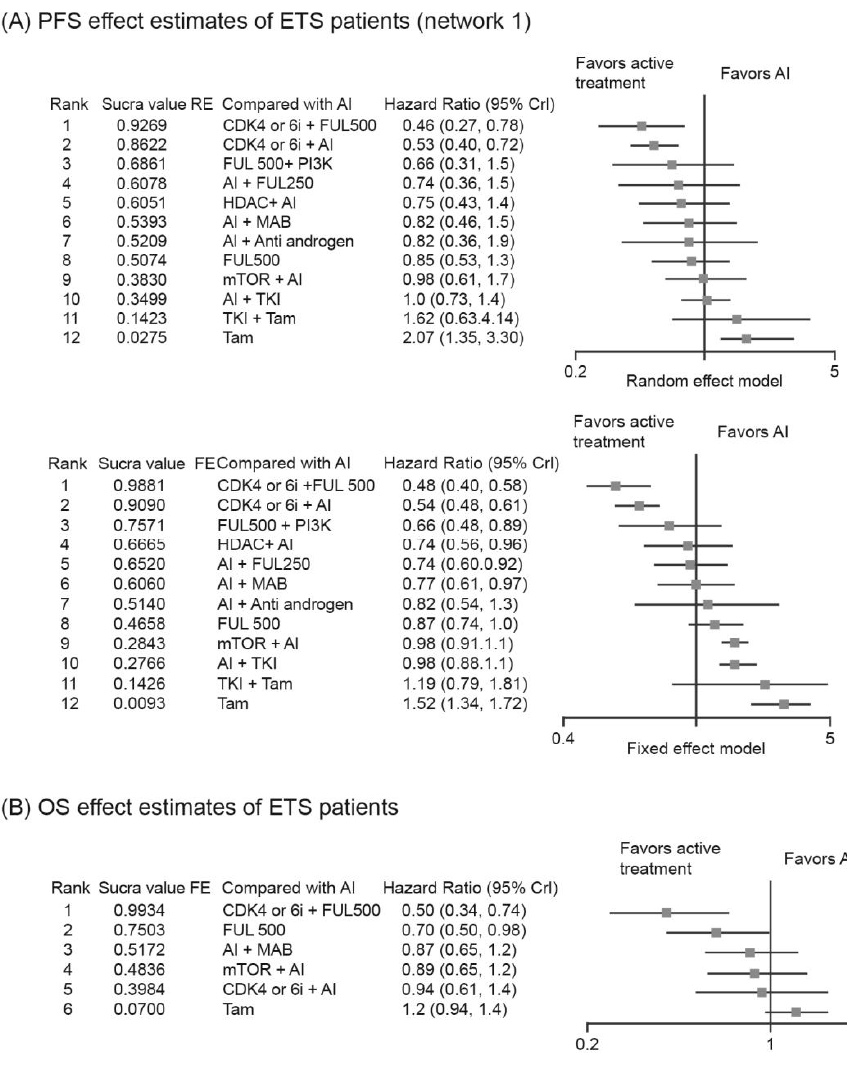
Figure 3. SUCRA values for treatment regimens and relative effect. ( A ) PFS effect estimates of ETS patients (network 1); ( B ) OS effect estimates of ETS patients (network 1).